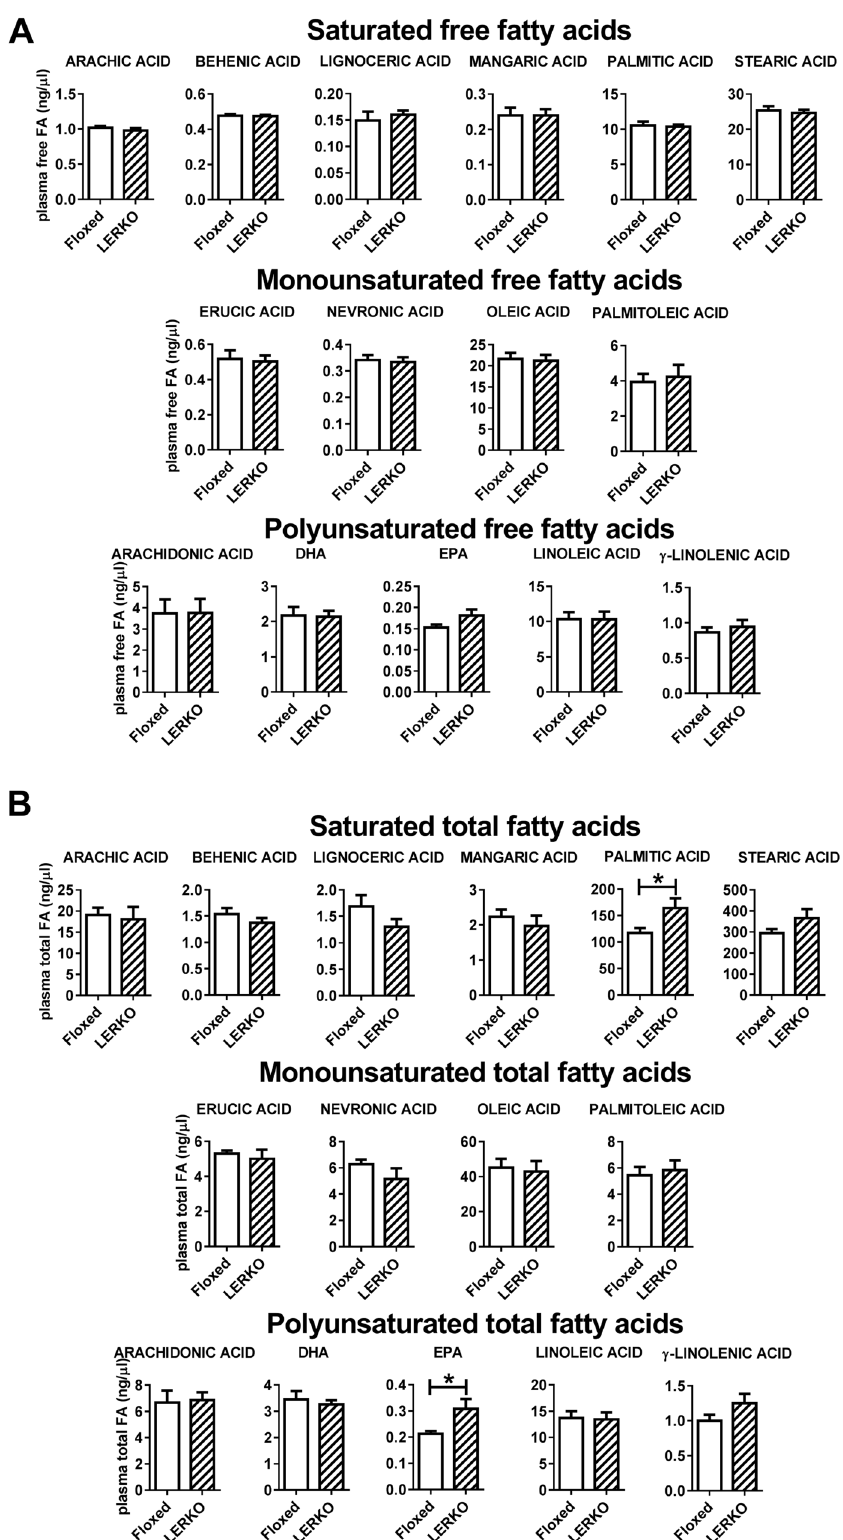
Figure 6. Total palmitic acid and EPA are increased in the plasma of LERKO mice. The content of free and total fatty acids indicated was measured in the plasma of floxed and LERKO mice in E by LC-MS/MS. Data shown is combined results of 2 separate experiments (N = 4–5 mice/exp). Statistical significance was assessed by two- tailed unpaired t-test. * p < 0.05, Fig. 6B: palmitic acid, p = 0.0327, DF = 11, t = 2.443, EPA, p = 0.0352, DF = 10, t = 2.434, EPA, p = 0.0352, DF = 10, t =